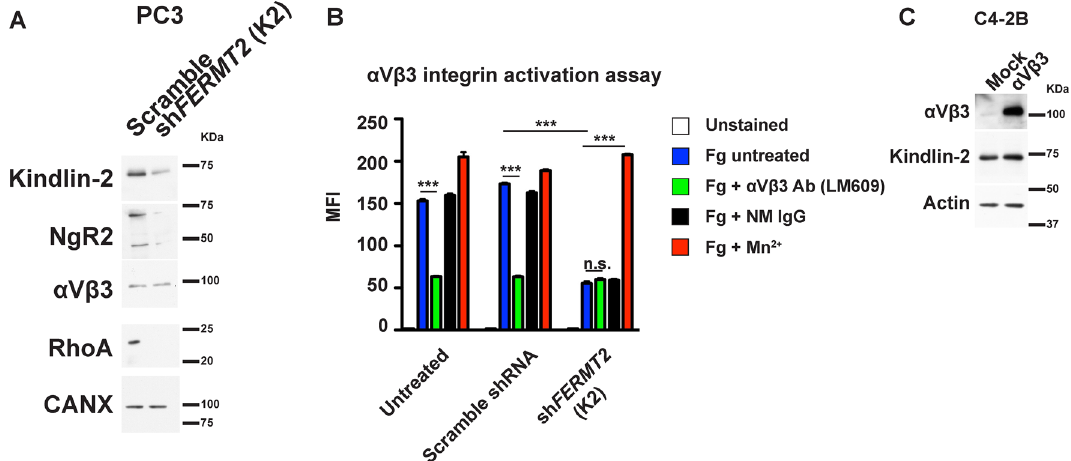
Figure 7. The αVβ3 integrin must be active to induce NgR2 in PrCa cells. ( A ) Immunoblotting analysis of the expression levels of Kindlin-2, NgR2, αVβ3, and RhoA in the lysates from PC3 cells in which Kindlin-2 expression was downregulated using shRNA targeting FERMT2 (the gene responsible for Kindlin-2). CANX was used as loading control. ( B ) Flow cytometry analysis of αVβ3 activation by its capacity to bind soluble Fg-Alexa Fluor 488 in PC3 cells transfected with a shRNA against FERMT2 or the non-targeting shRNA control (n = 2). Values are reported as Mean Fluorescence Intensity (MFI), and P -values were calculated by unpaired t-test using GraphPad Prism. ( C ) Immunoblotting analysis of the expression levels of the αVβ3 integrin and Kindlin-2 in C4-2B cells that express the αVβ3 integrin or their mock control. Actin was used as loading control. All immunoblotting analyses were performed under reducing conditions. n.s., non-significant; *** P <